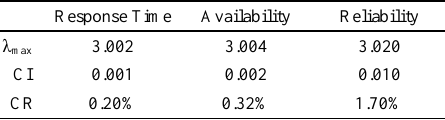
Table 6. Consistency evaluation for Case 1